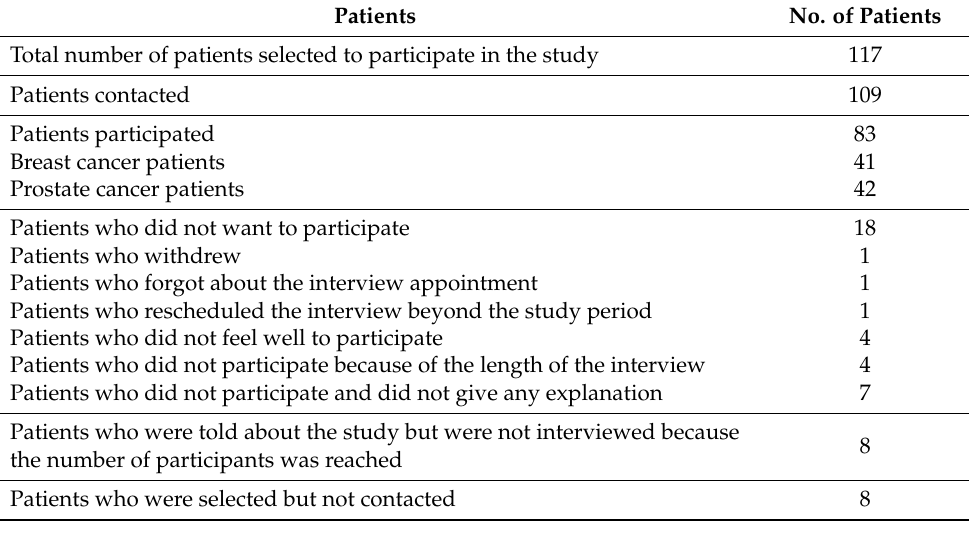
Table A1. Patients selected and contacted for the